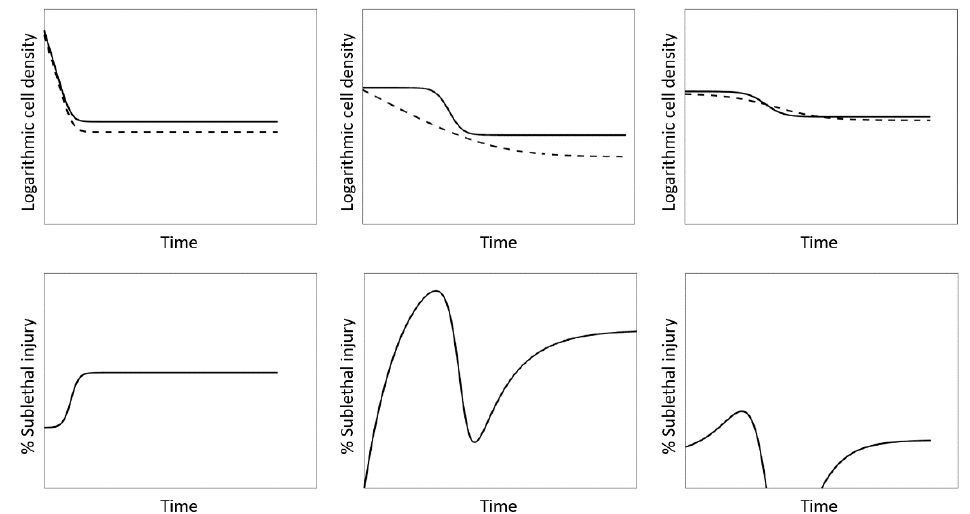
Figure 1. Examples of artefacts occurring due to calculating SI directly from non-log transformed model fit values. The modelled evolution of the population density on non-selective (—) and selective (- - -) medium is presented in the top row and the resulting SI in the bottom row. Both are presented as a function of unitless time. Left: long periods of constant SI caused by consecutive differences in model fits on the non-selective and selective medium. Middle: strange SI evolution caused by differences in model output shapes on non-selective and selective medium. Right: negative values in the SI evolution caused by intersecting model fits on the non-selective and selective media. For each case, top figures represent the model fits to non-selective and selective media, while bottom figures represent the SI calculated according to Equation (1).